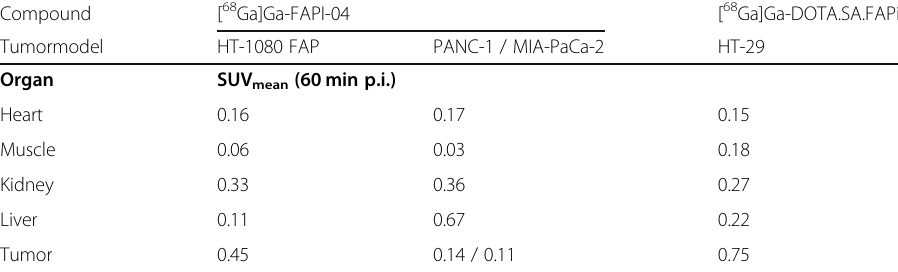
Table 2 Comparison of [ 68 Ga]Ga-FAPI-04 and [ 68 Ga]Ga-DOTA.SA.FAPi: SUV mean values of μ PET measurements at 60 min p.i. with the corresponding tumor models. The values of the FAPI-04 component are obtained from the reference literatures (Lindner et al. 2018; Watabe et al. 2020) Compound [ 68 Ga]Ga-FAPI-04 [ 68 Ga]Ga-DOTA.SA.FAPi Tumormodel HT-1080 FAP PANC-1 / MIA-PaCa-2 HT-29 Organ SUV mean (60 min p.i.) Heart 0.16 0.17 Muscle 0.06 Kidney 0.33 Liver 0.11 Tumor 0.45 0.75 The values from references were read from the graphs and therefore do not indicate precise